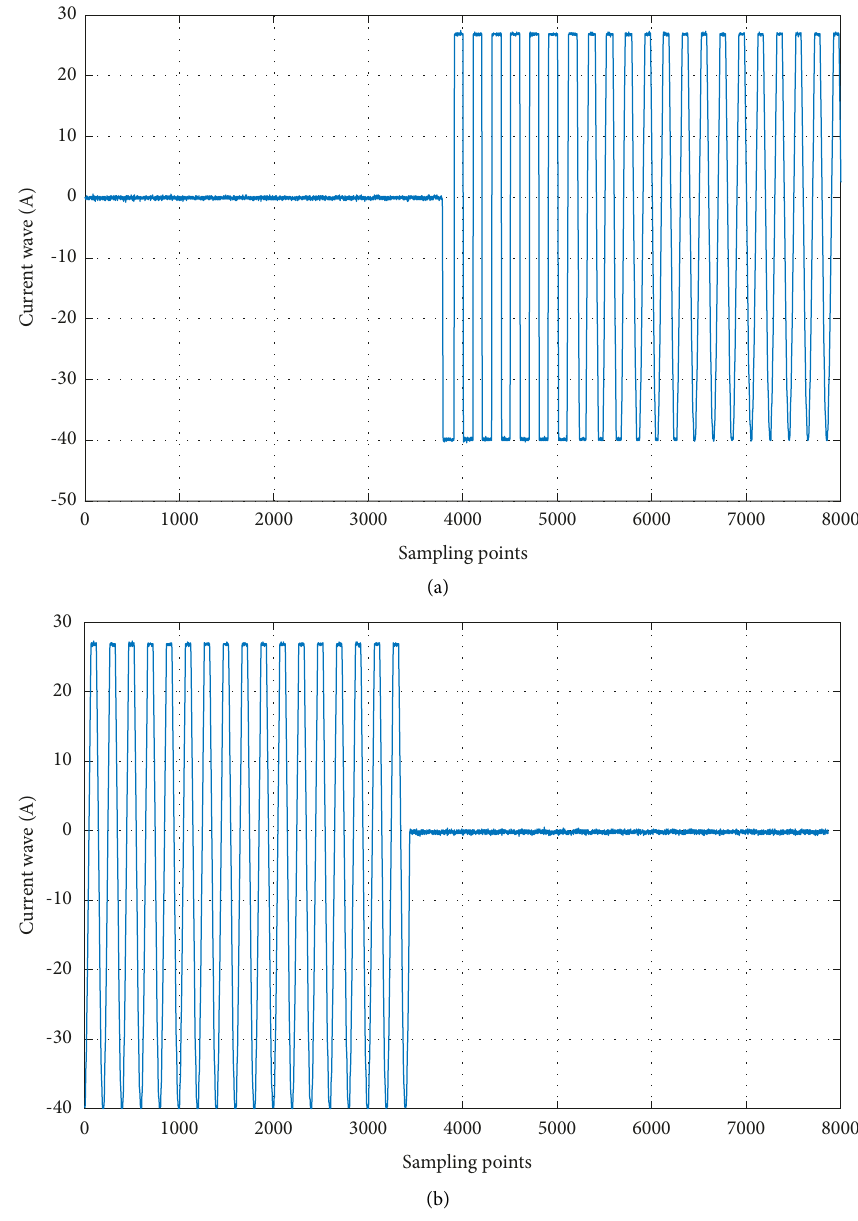
Figure 1: Current change of on/off events for cement screw. Table 1: Load steady-state feature indices of industrial